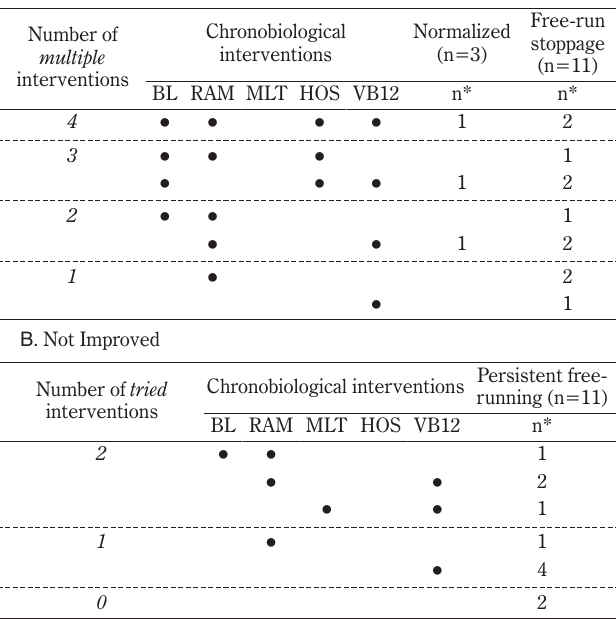
Table 3 Treatment outcomes and chronobiological interventions A.